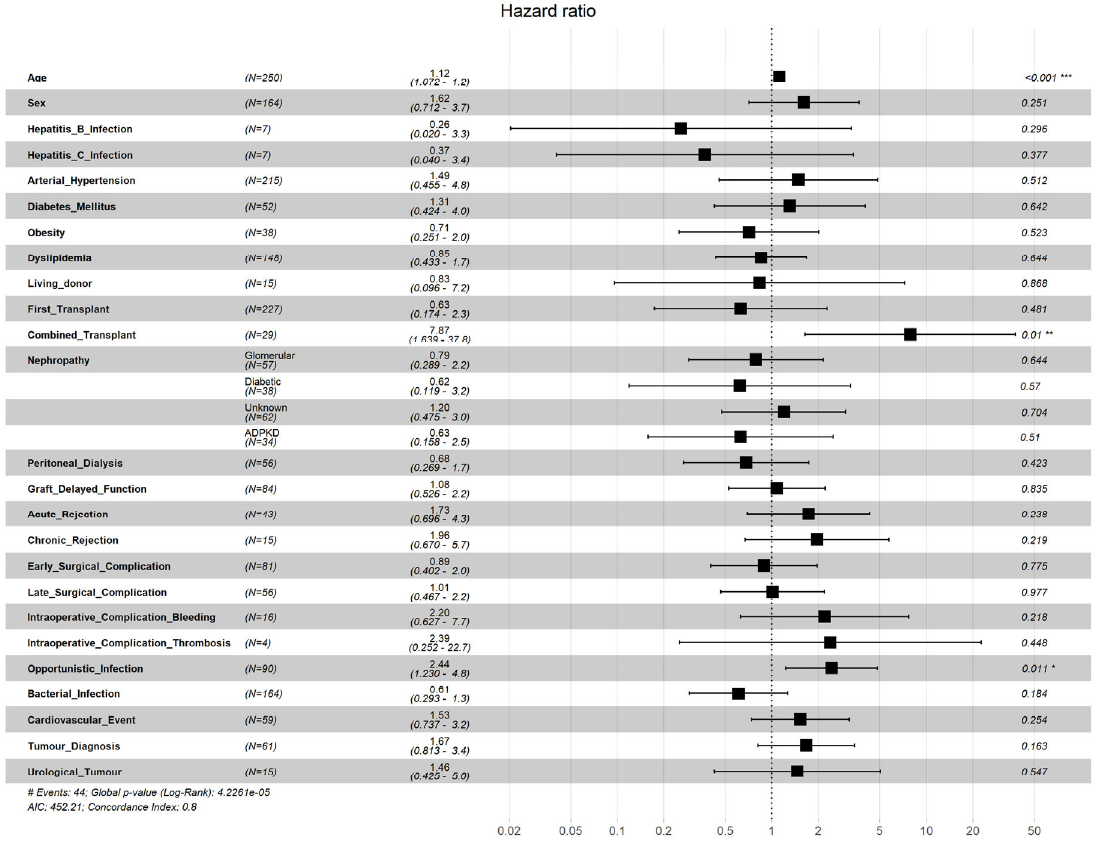
Figure 1. Overal Survival Curve (Kaplan ‐ Meier method model).